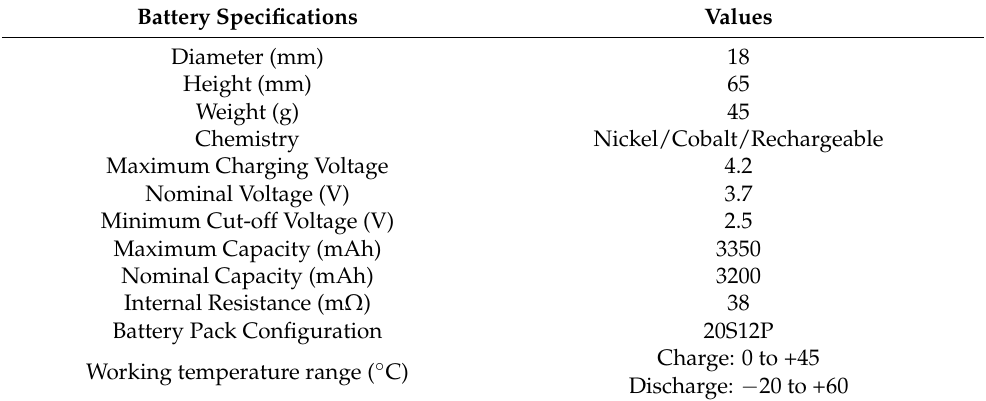
Table 1. Specifications of 3.2 Ah battery